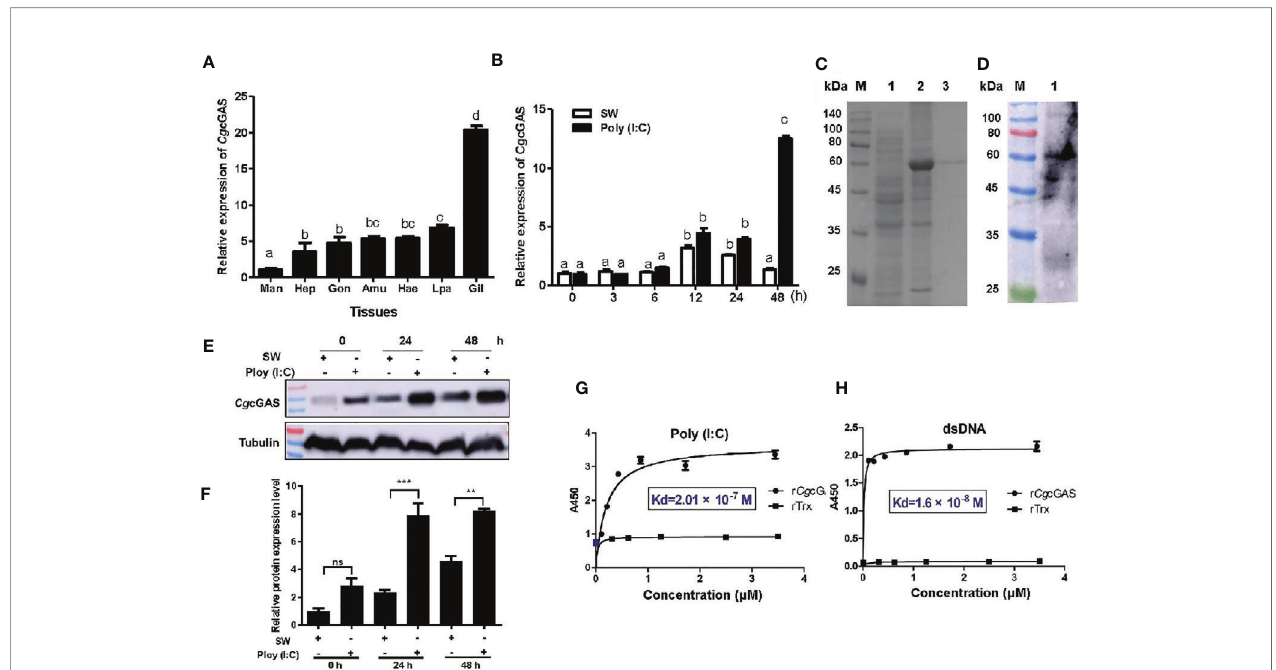
FIGURE 2 | The binding activity of Cg cGAS to viral nucleic acid. (A) The tissue distribution of Cg cGAS mRNA. Man, mantle; Hep, hepatopancrease; Gon, gonad; Amu, adductor muscle; He, hemolymph; Lpa, labial palp; Gil, gill. (B) The temporal mRNA expression of the Cg cGAS after Poly (I:C) stimulation in hemocytes. (C) The recombination protein of Cg cGAS. Lane M: standard protein molecular weight marker; Lane 1: negative control (without induction); Lane 2: induced r Cg cGAS; Lane 3: puri fi ed r Cg cGAS. (D) Lane 1: the speci fi city of polyclonal antibody for Cg cGAS detected by Western blot. (E) The protein level of Cg cGAS after Poly (I:C) stimulation. (F) The statistical analysis of Cg cGAS protein level using ImageJ. (G) The binding activity of r Cg cGAS towards Poly (I:C) and (H) dsDNA. A450 was the absorbance value at 450 nm, and the Kd values were calculated by GraphPad Prism 5. ** p < 0.01; *** p < 0.001; ns, not signi fi cant. The different letters show the existence signi fi cant differences comparing with other groups ( p <